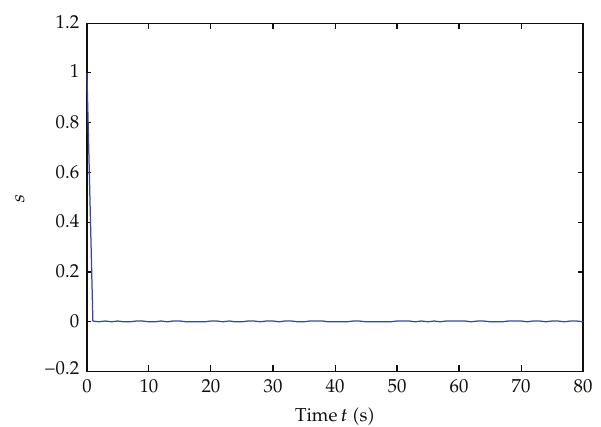
Figure 5: The time domain chart of sliding